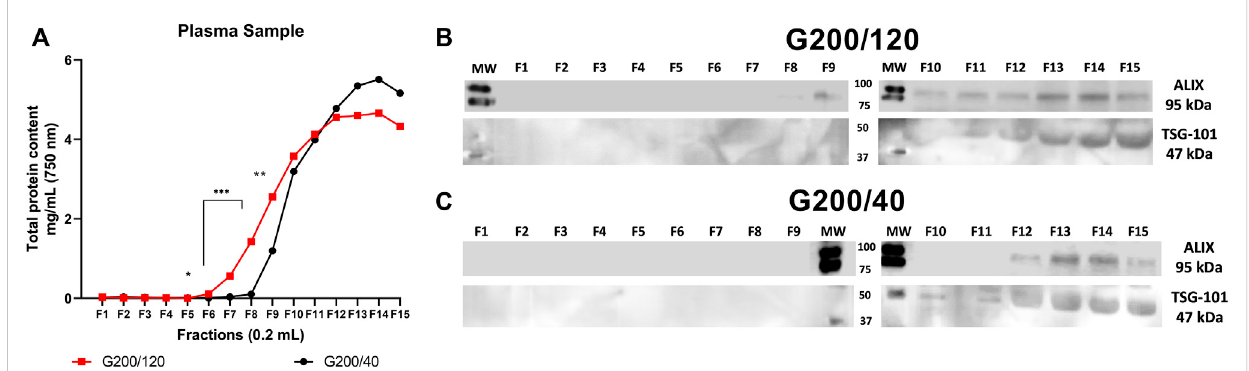
FIGURE 4 Protein pro fi le fractions and Western blot analysis from the plasma sample. Plasma was pre-treated according to Material and Methods, and 500 µL of the sample was loaded on G200/120 and G200/40 columns. For each fraction (200 µL), the total protein was measured. (A) Protein elution pro fi le for the plasma sample collected fractions. (B) Western blot analysis for ALIX and TSG-101 of the collected fractions from G200/120 column and (C) from G200/40 column.Statisticaldifferenceswereobserved betweenfractionsF6toF10.(*) p < 0.05,(**) p < 0.01,(***) p <